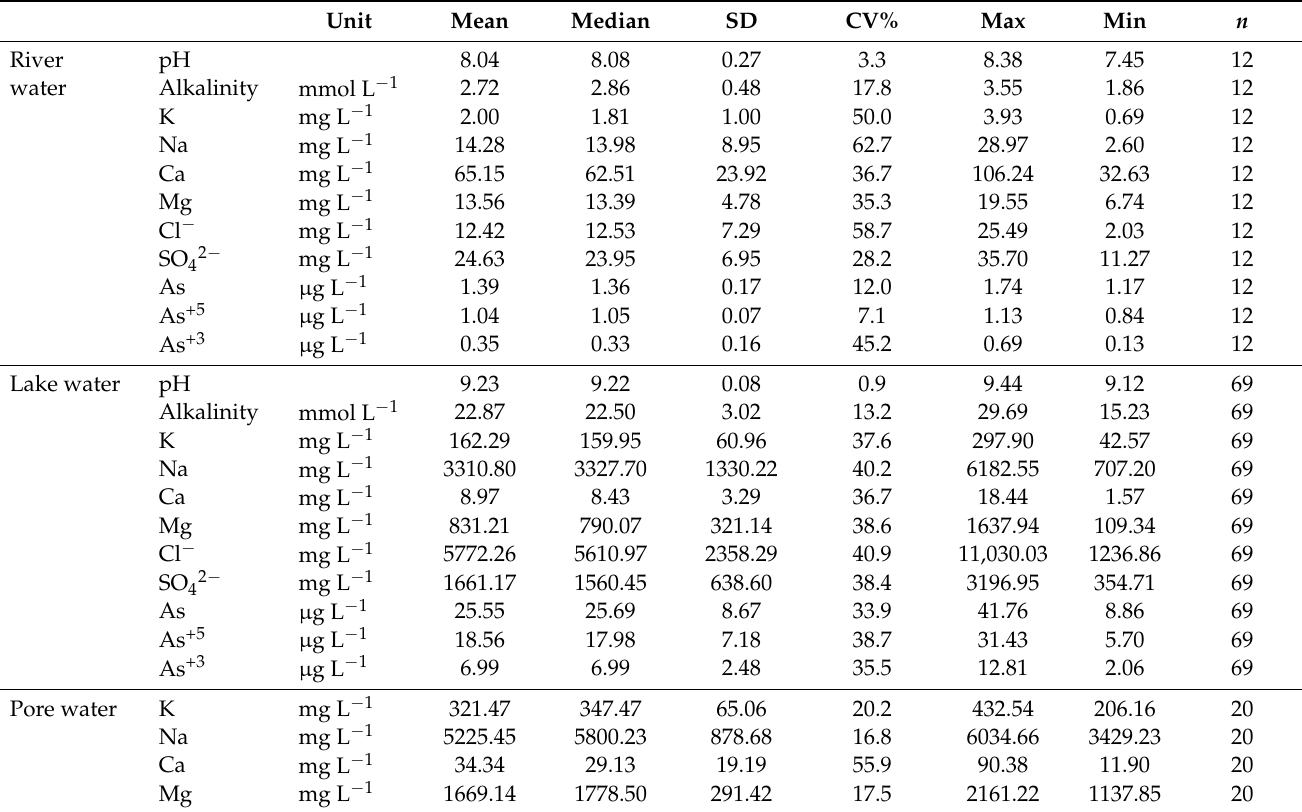
Table 2. Statistical values of physicochemical parameters for the water, sediment, and